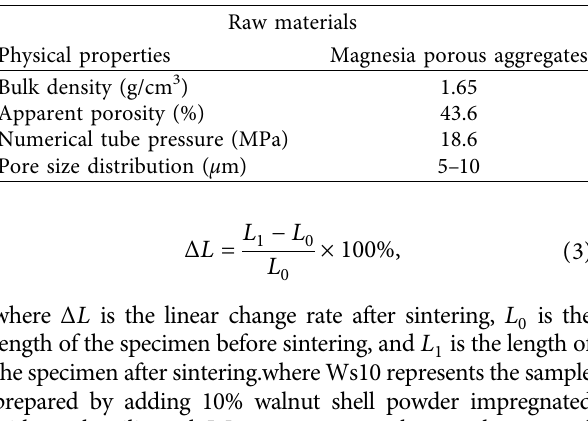
Figure 4: (a) Structural diagram of the inner and outer surfaces of the silica sol. (b) Schematic diagram of the surface principle of the silica sol-impregnated walnut shell powder. Table 1: The physical properties of sintered magnesia porous